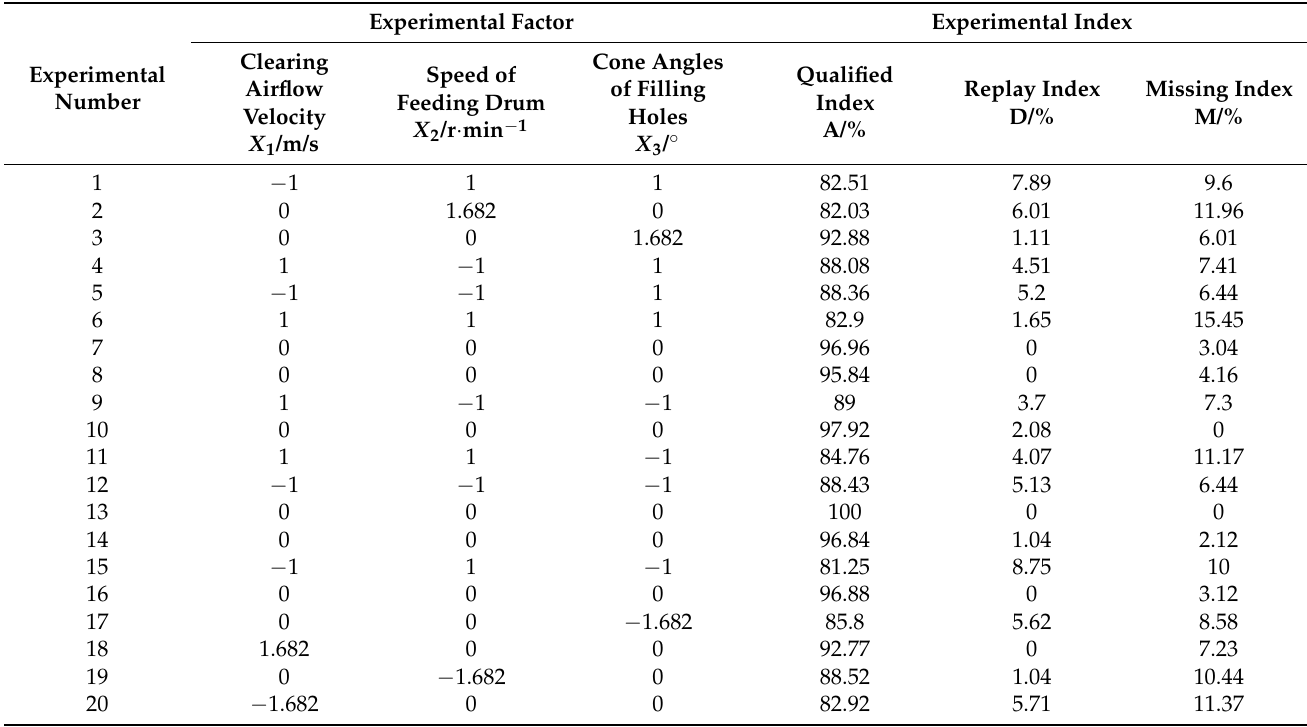
Table 2. Protocols and